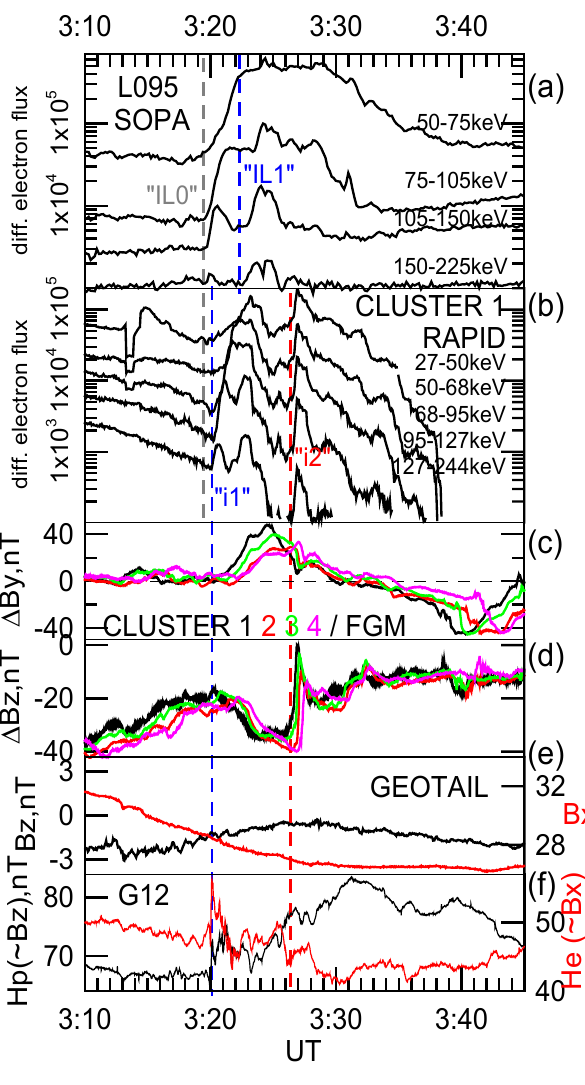
Fig. 3. L095/SOPA energetic electrons (a) , Cluster 1/RAPID (b) , Cluster FGM B Y (c) ; B Z (d) ; Geotail B X and B Z magnetic field components (e) ; G12 H p and H e (f)